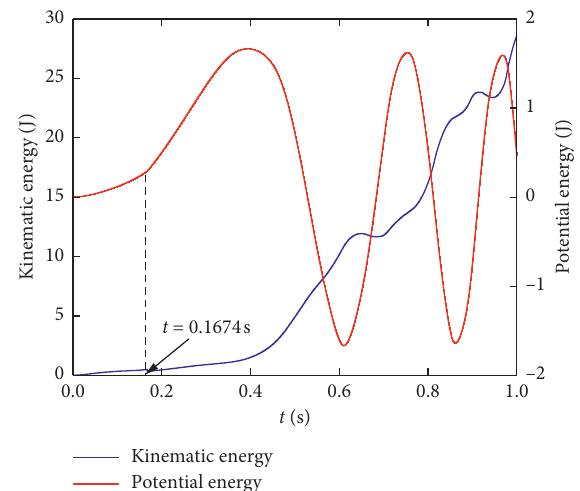
Figure 9: Energy variation of the system.